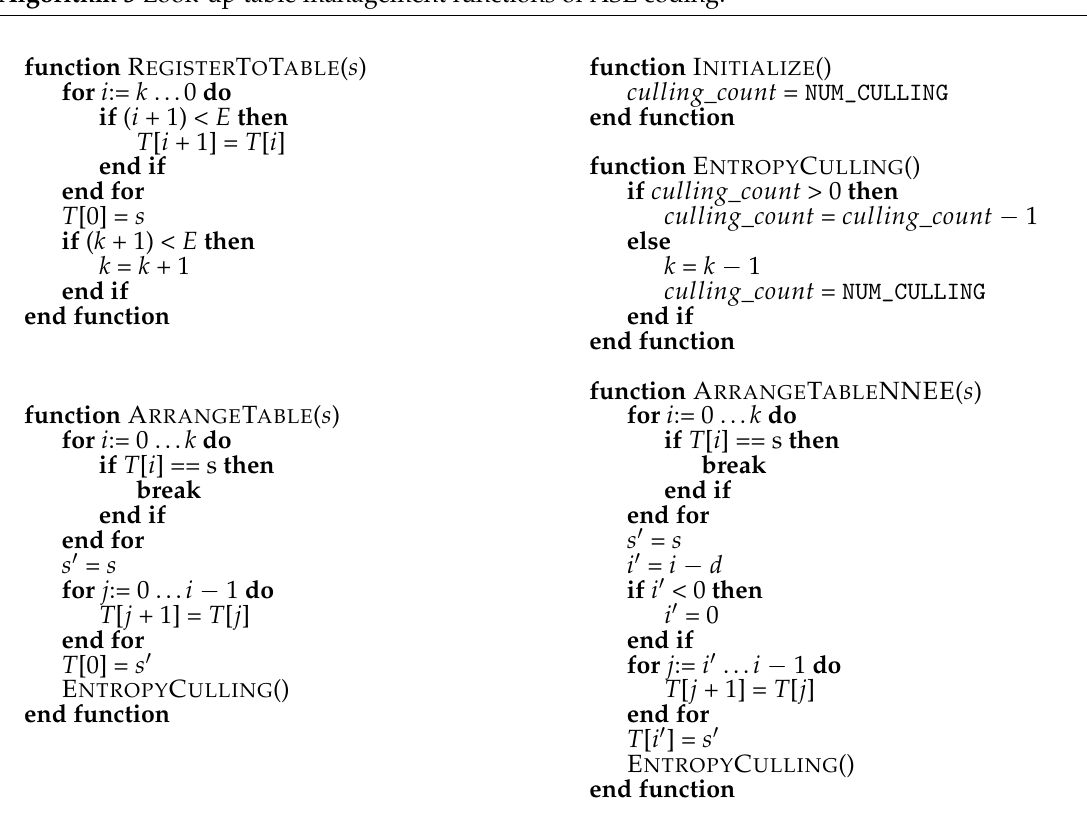
Algorithm 3 Look-up table management functions of ASE